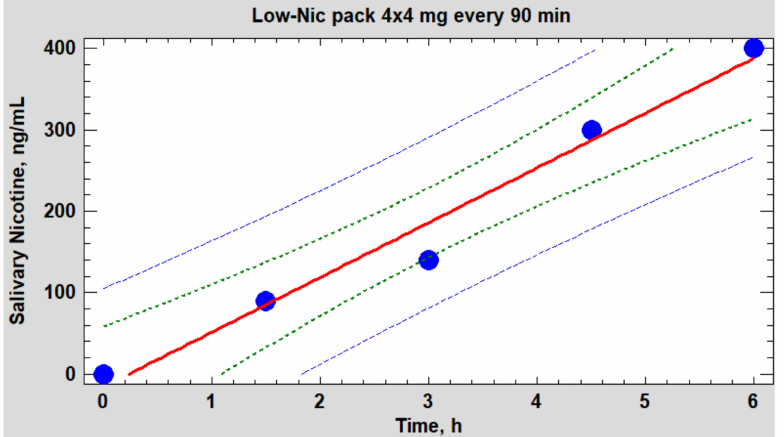
Figure 12. Dynamics of nicotine in saliva (collection of saliva every 45 min immediately before using the next pack). Regression line (red) p = 0.0018. 95% confidence level (green